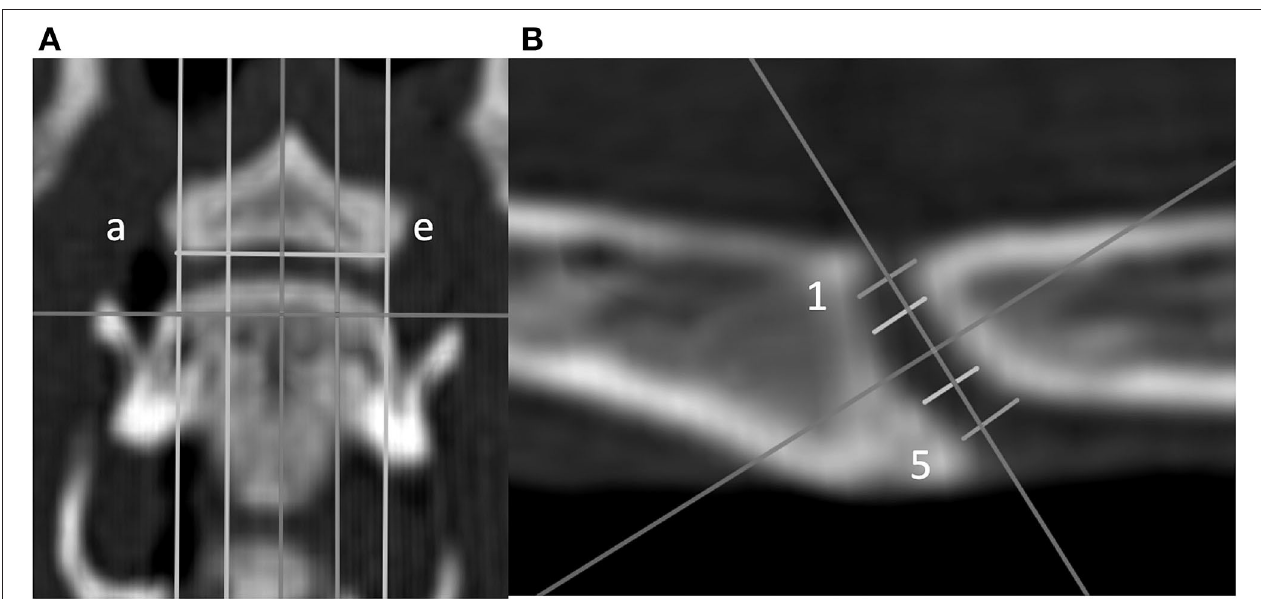
FIGURE 3 | Dorsal (A) and sagittal (B) CT images of a feline vertebral specimen. (A) The image is at the level of the dorsal tip of the caudal vertebral endplate. Lines a through e are equidistant and parallel and divide the intervertebral disc (IVD) space into five sagittal planes. (B) Sagittal view corresponding to line c (midline on the dorsal view). Five lines (labeled 1 through 5 from dorsal to ventral) were drawn equidistant and parallel to each other. Measurement of the IVD width was determined for these